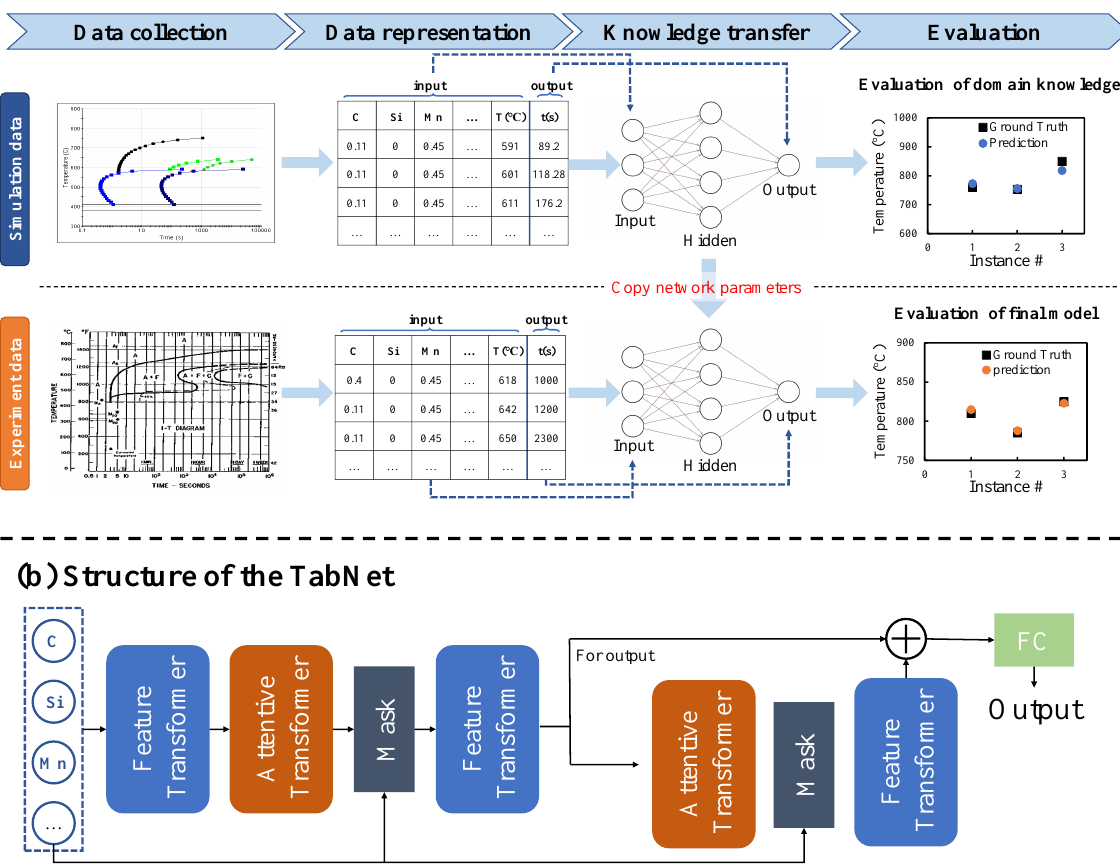
Figure 2. The workflow of the proposed framework. ( a ) The workflow in turn includes data collection, data representation, knowledge extraction, and knowledge transfer. Two types of datasets are collected: a large-scale simulation dataset from simulation software and a regular-sized experiment dataset from published literature. After data representation, the simulation dataset is trained first, and then the learned knowledge is transferred to the training of the experiment dataset by sharing model parameters. ( b ) The architecture schematic of deep neural